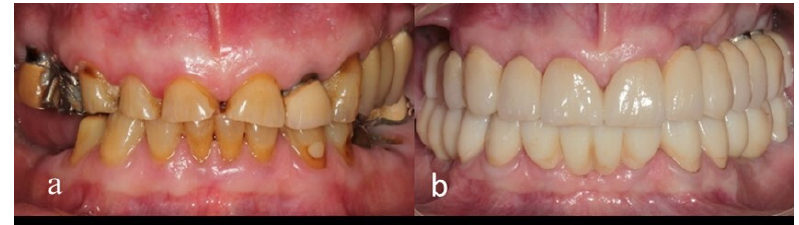
Figure 1. Patient 3: ( a ) Before treatment; ( b ) After treatment.